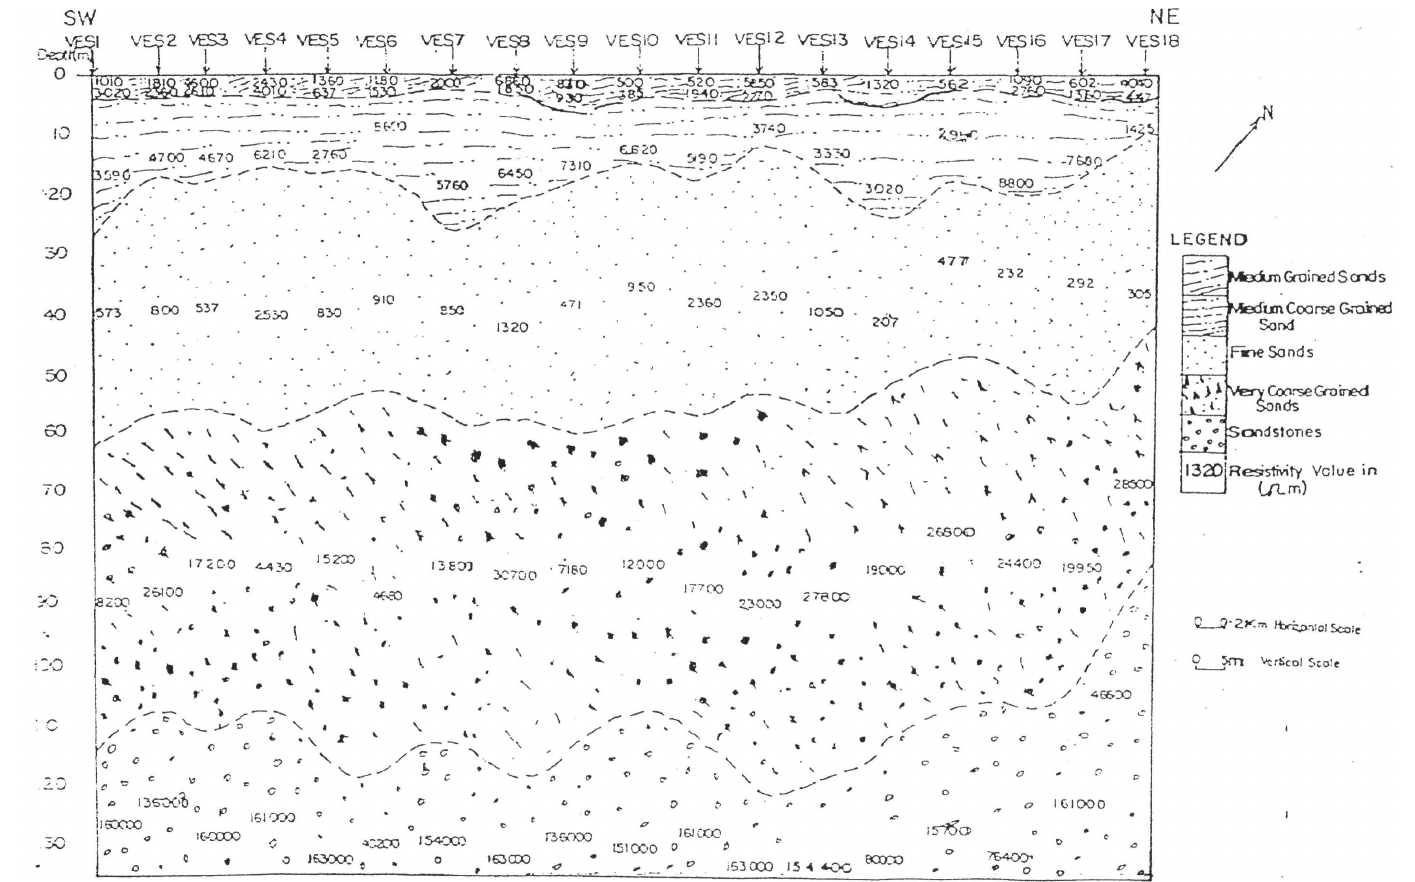
Figure 3. Southwest-Northeast geoclectric section in the study